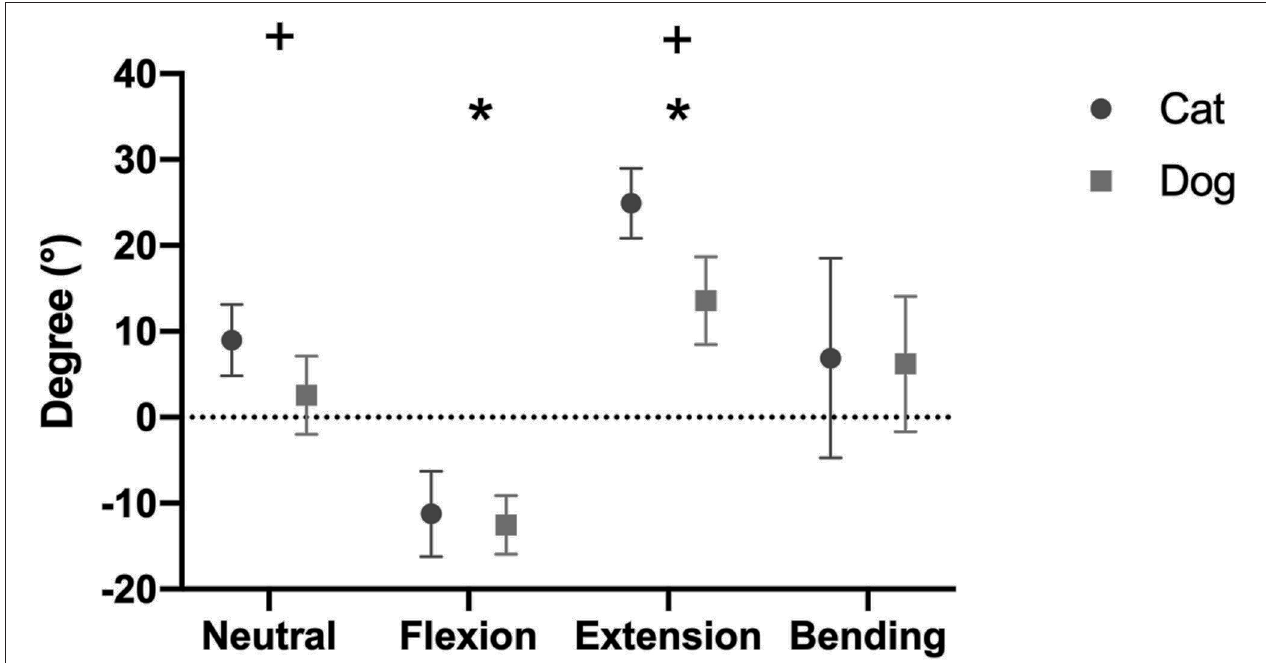
FIGURE 5 | Intervertebral disc (IVD) wedge angles (mean degree ± SD) for the feline and canine spinal specimens in different loading conditions. Canine specimens originated from small dogs. Positive values indicate that the angle opened ventrally, whereas negative values indicate that the angle opened dorsally. *indicates a significant difference between one loading condition and all other loading conditions ( p < 0.05). + indicates a significant difference between dogs and cats for a specific loading condition ( p < 0.05).